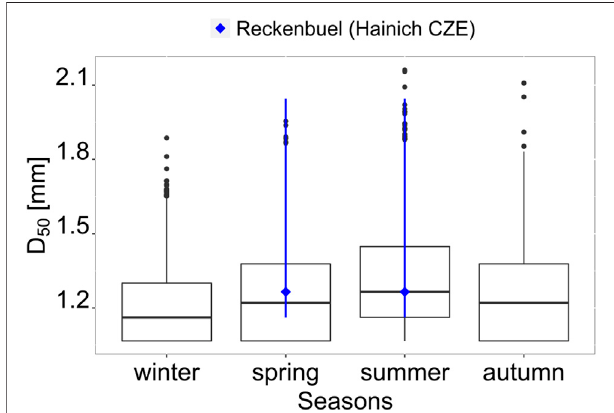
FIGURE 2 | Median rain drop size (D 50 in mm) derived from hourly rain intensity measured over 15 years (2004 – 2019) from a nearby German Weather Service precipitation gauge (DWD climate data centre, www.dwd. de/cdc, ID 336, located 12 km to the Southeast). Blue lines mark the drop size range derived from data measured by the nearby Reckenbuel station (1.4 km to the Northeast) from 13 March 2019 to 28 August 2019.